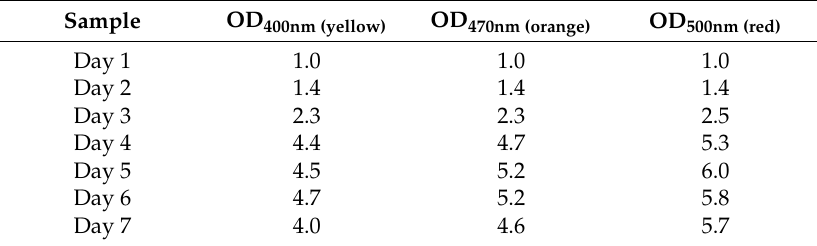
Table 1. Pigment production by M. purpureus CWT715 during fermentation for seven days.